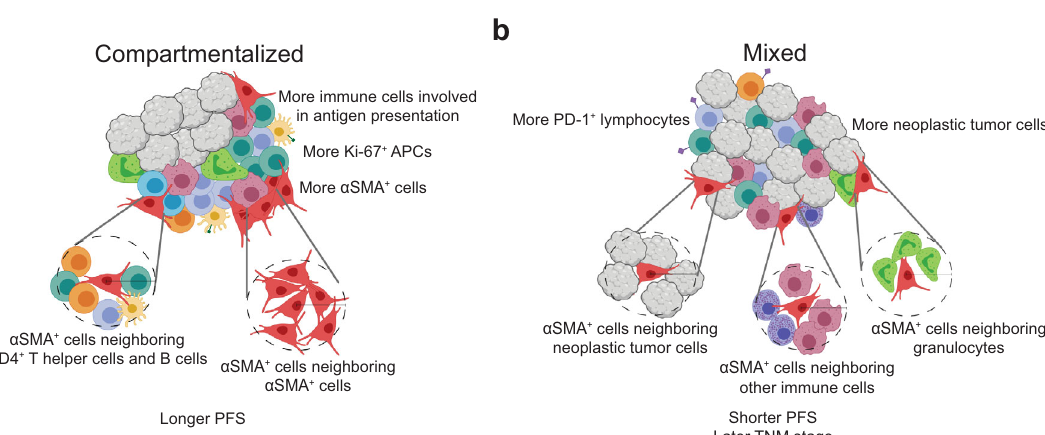
Fig. 5 Proposed model of primary HPV( − ) HNSCC tumor-immune microenvironments. a Depiction of a tumor with a compartmentalized spatial architecture. These tumors have decreased mixing between immune cells and neoplastic tumor cells and tend to contain greater immune cell density, speci fi cally cells involved in antigen presentation, as well as increased density of α SMA + mesenchymal cells. The α SMA + cells present tend to be neighbored by CD4 + T helper cells and B cells, as well as other α SMA + cells. Compartmentalized primary tumors were found to be associated with longer progression-free survival. b Depiction of a tumor with a mixed spatial architecture. These tumors contain increased mixing between immune cells and neoplastic tumor cells and tend to contain increased neoplastic tumor cells, as well as increased PD-1-positive lymphocytes. The α SMA + cells present tend to be neighbored by neoplastic tumor cells, other immune cells, many of which are CD163 + or are mast cells, and granulocytes. Mixed primary tumors were found to be associated with shorter progression free survival and later TNM stage. This fi gure was created using